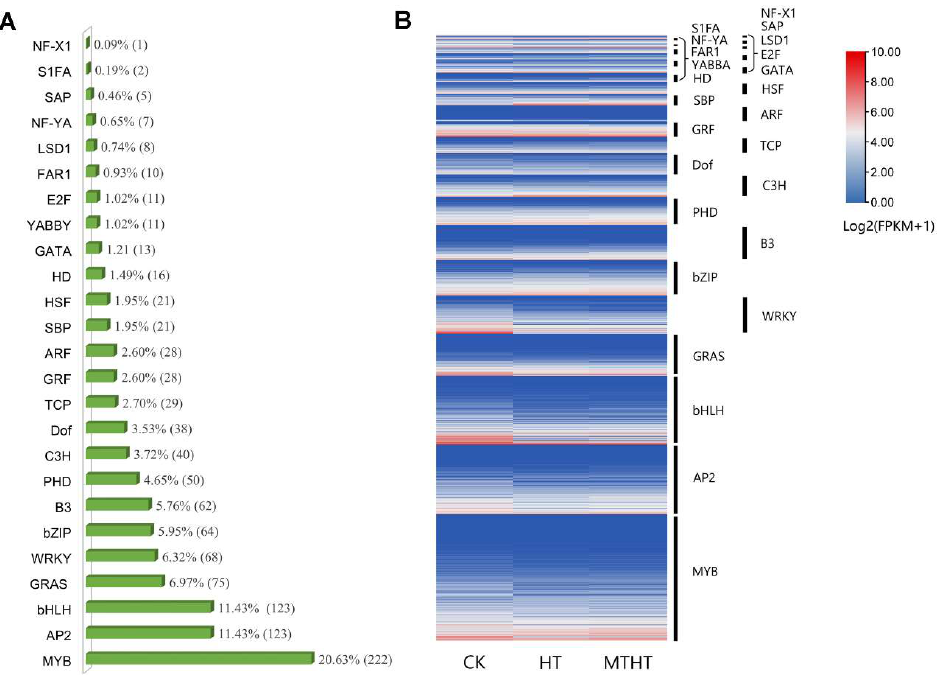
Figure 4. Celery transcription factor under heat stress. ( A ) Differentially expressed transcription factor genes. The percentage is the ratio of the number of members of each transcription factor family to the total number of members of all celery transcription factors. ( B ) Specific expression of tran-scription factors. Colors from blue to red represent expression levels from low to high, which were calculated using log2 (FPKM+1). The heat maps label the family of transcription factors.